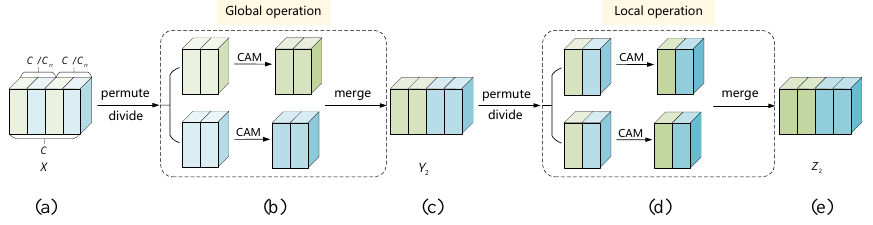
Figure 6. The structure of the proposed sparse channel self-attention module (SCAM). ( a ) The input image is divide along the channel dimension. ( b ) CAMs are performed in rearranged sub-channels. ( c ) The channels of the feature map are resorted to the original combination. ( d ) CAMs are performed in resorted sub-channels. ( e ) The output of SCAM is